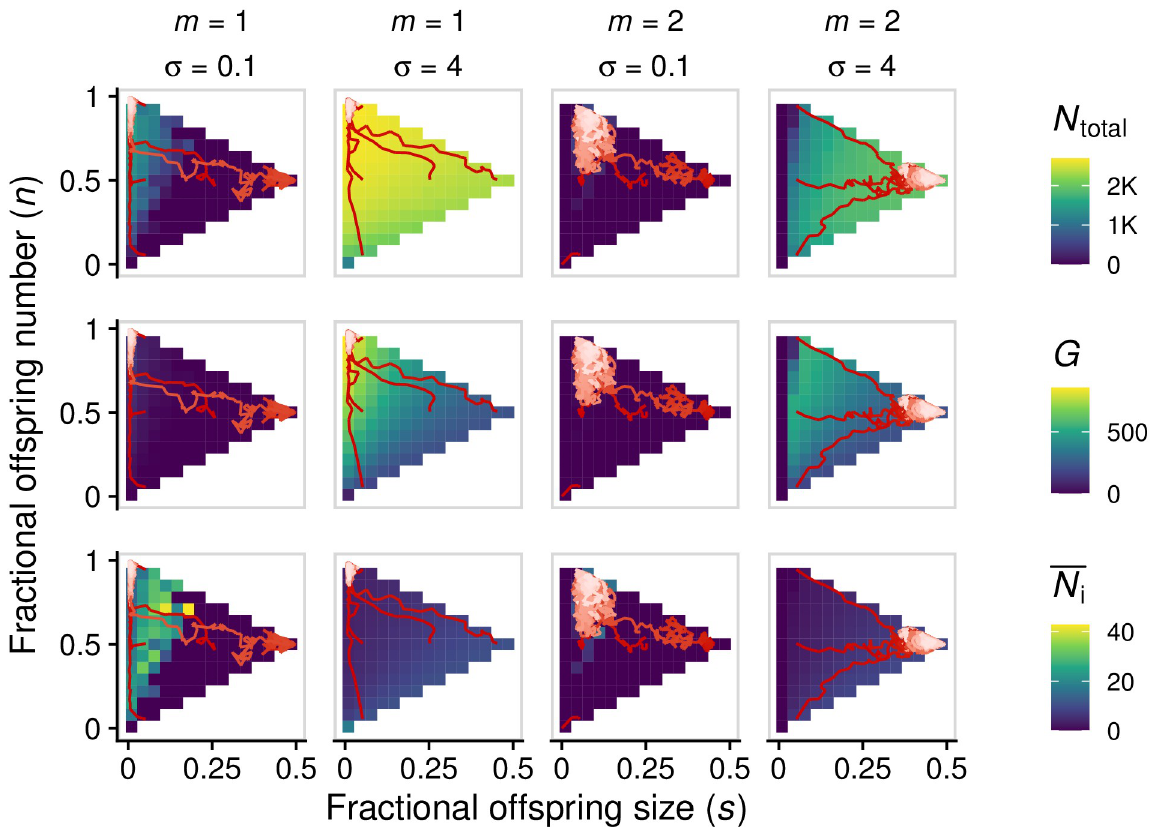
Fig 6. Evolution of fragmentation mode maximizes total number of cells ( N total , top row) rather than other quantities such as number of groups ( G , middle row) or average group size ( � N , bottom row). Red lines represent evolutionary trajectories of the average mode of i fragmentation over time (darker shades of red correspond to earlier time points). For each value of σ , we assessed five initial phenotypes. Parameters: all parameters are set to the default values, unless otherwise indicated (Table A in S1 Text), except: K cells = 100, B 0 = 0.01, K total = 30, 000 (when σ = 0) or K total = 10, 000 (otherwise), μ s = μ n = 10 − 2